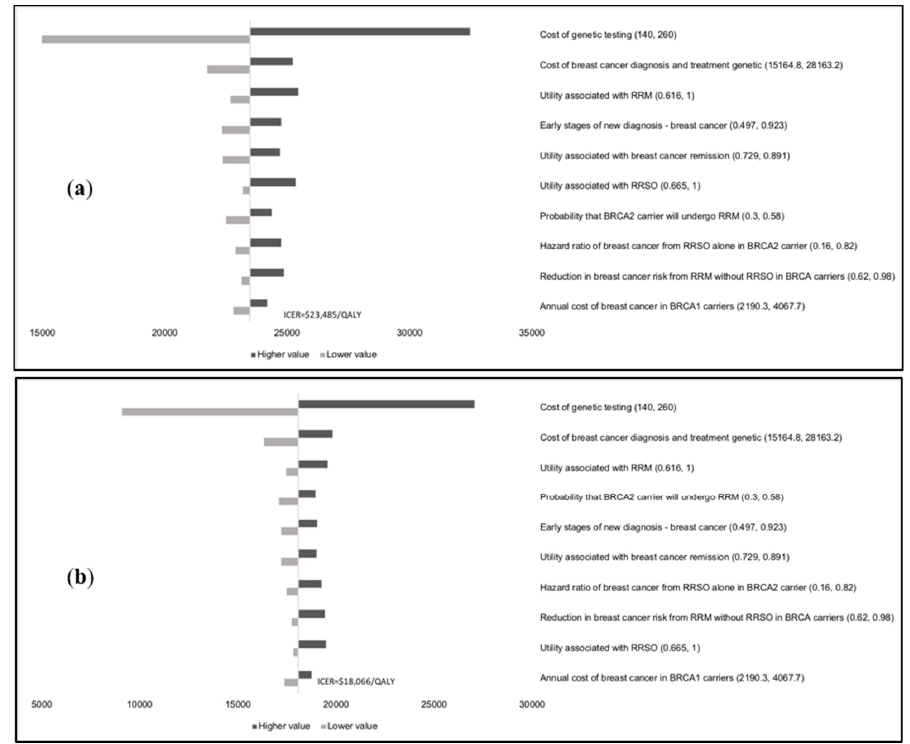
Figure A4. Tornado Diagram in China ( a ) from the healthcare payer perspective. ( b ) from the societal perspective.